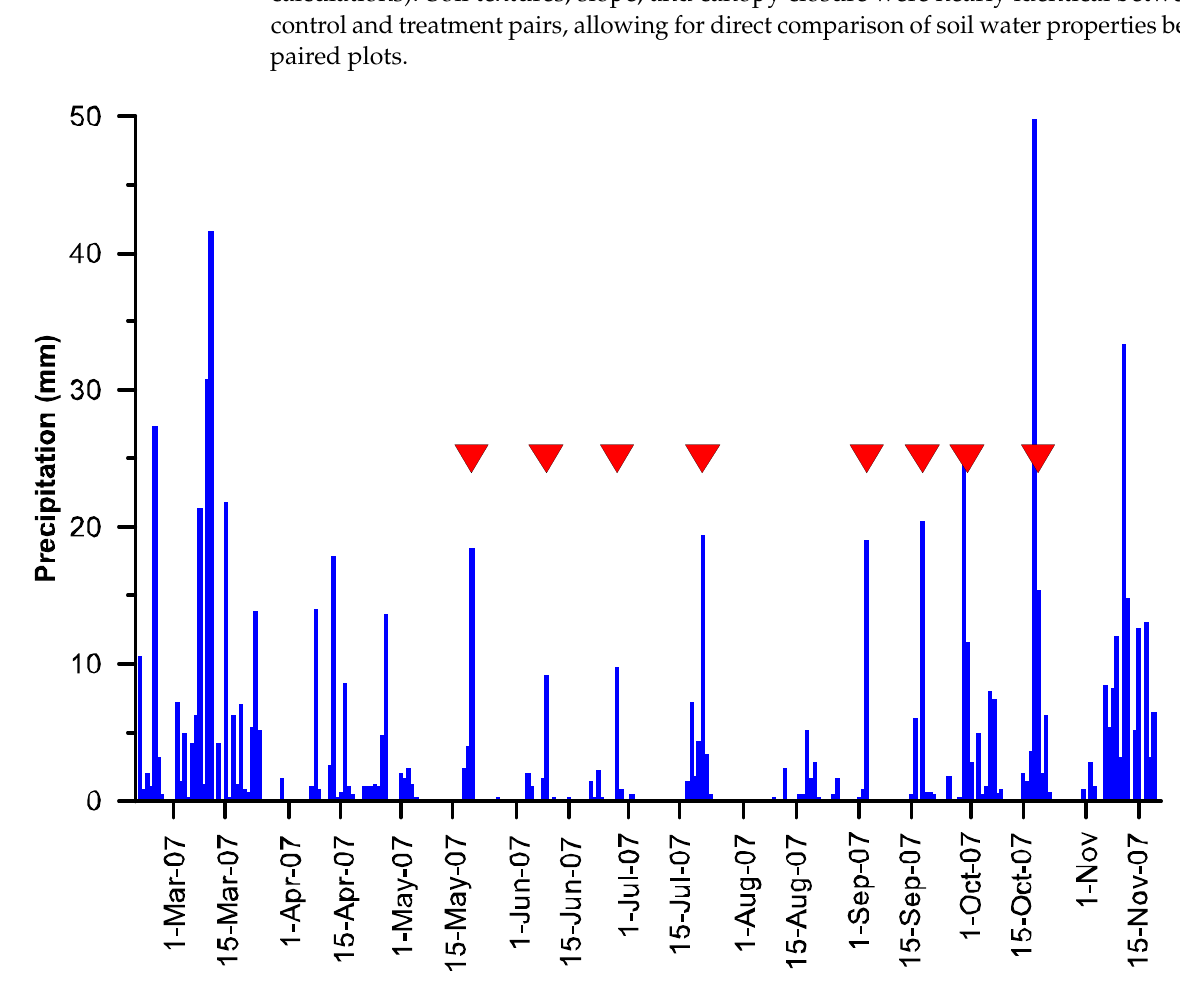
Figure 1. Precipitation observed at Kelvin Creek, Duncan, BC, Canada, from 20 February to 20 November 2007. The red triangles indicate effective input precipitation events considered in this analysis.